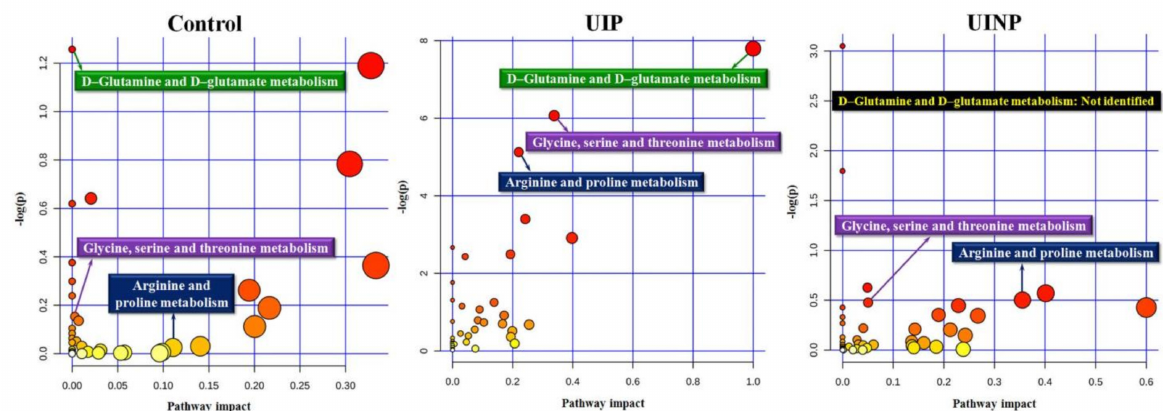
Figure 3. Identified metabolic pathways associated with FMP ratio in Control, UIP, and UINP. Control: Control group; UIP: Urinary incontinence group with Pilates; UINP: urinary incontinence group with no Pilates; pathway impact: statistical value calculated based on the metabolic importance of matched metabolites in each pathway, which uses the pathway topology analysis using the relative-betweeness